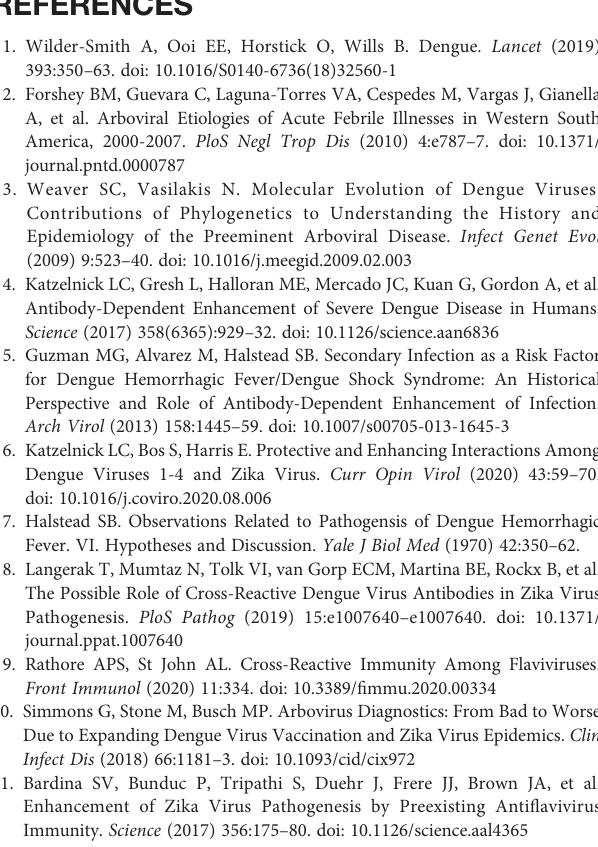
Supplementary Figure 12 | Identi fi cation of DENV speci fi c and fl avivirusbroadly immunogenic epitopes in C, NS2A, NS2B, NS4A amd NS4B. IgM and IgG targeted epitopes at the E (A) and NS1 (B) proteins from DENV, ZIKVandYFV viruses, recognized byDENVpatients were fi ltered out andmappedto the proteomic coordinates of DENV (Uniprot ref: P33478). Colored barsfrom light-yellow to orange represent immunodominant regionsbelonging to one DENV serotype. Red bars represent immunodominant regionsbelonging to more than one serotype here called PanDENV. Green barsrepresent immunodominant regionsbelonging to DENV and ZIKVor/and YFV here called PanFlavi. For both panelsthe protein domainsandthe percentage identities are as in SupplementaryFigureS8 . Red arrows are peptides which Absresponses are further detailed in SupplementaryFigureS13 . Purple and cyanarrowscorrespondtoYFVandZIKVpeptidespreviouslyidenti fi edasZIKVspeci fi c byMishra et al. (31). Supplementary Figure 13 | Heat map showing DENV-speci fi c and PanFlavi peptides targeted byIgMand IgG Abs. Heatmapsdepicting the Ab reactivity from endemicpatients,travelerpatientsandnegativecontrolsagainsteachpeptide.Theleft panel correspond to IgG selectedpeptides while the right panel to IgM selected peptides. Each column represents a sample. The heatmap color scaleindicates the fl uorescenceintensitygoingfromlow(blue)tohigh(red).Eachrowrepresentsapeptide from the correspondent protein and the coordinates ofDENV (Uniprotref: P33478). Supplementary Figure 14 | HeatmapsshowingthehumoralresponseagainstZIKV andYFVATRs.IgG(A)andIgM(B)responsesfromtheendemicgroupagainstZIKVand YFVATRsweredividedintopatientswithhighneutralizingAbs(NAbs:(+)NTs,(+)PRNTs) titersor absent/lowNAbstitersagainstZIKVandYFV(see Table1 ). T1(acute),T2(early convalescent),T3(midconvalescent) andT4(late convalescent) samples.Eachcolumn representsasample.Theheatmapcolor scaleindicatesthe fl uorescence intensitygoing from low(light yellow) to high(red).